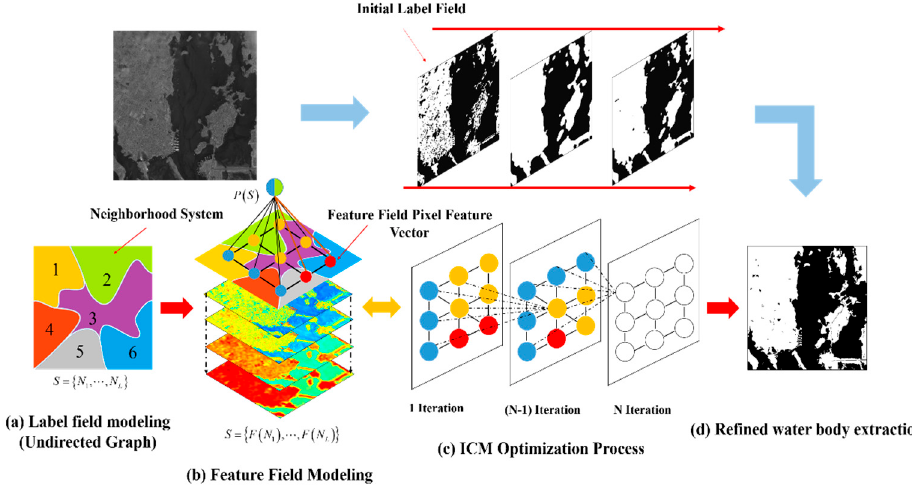
Figure 7. The workflow of Markov modeling for refined water body extraction. ( a ) is principle of label field modeling, ( b ) presents feature field modeling; ( c ) is ICM optimal iteration process, ( d ) is an example of extracted refined water body binary mask.